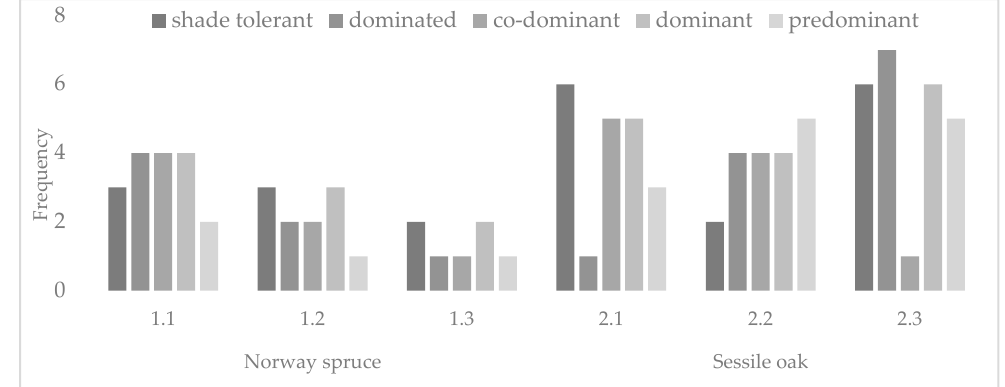
Figure 7. Vertical stand structure (Kraft classes) based on IDR.